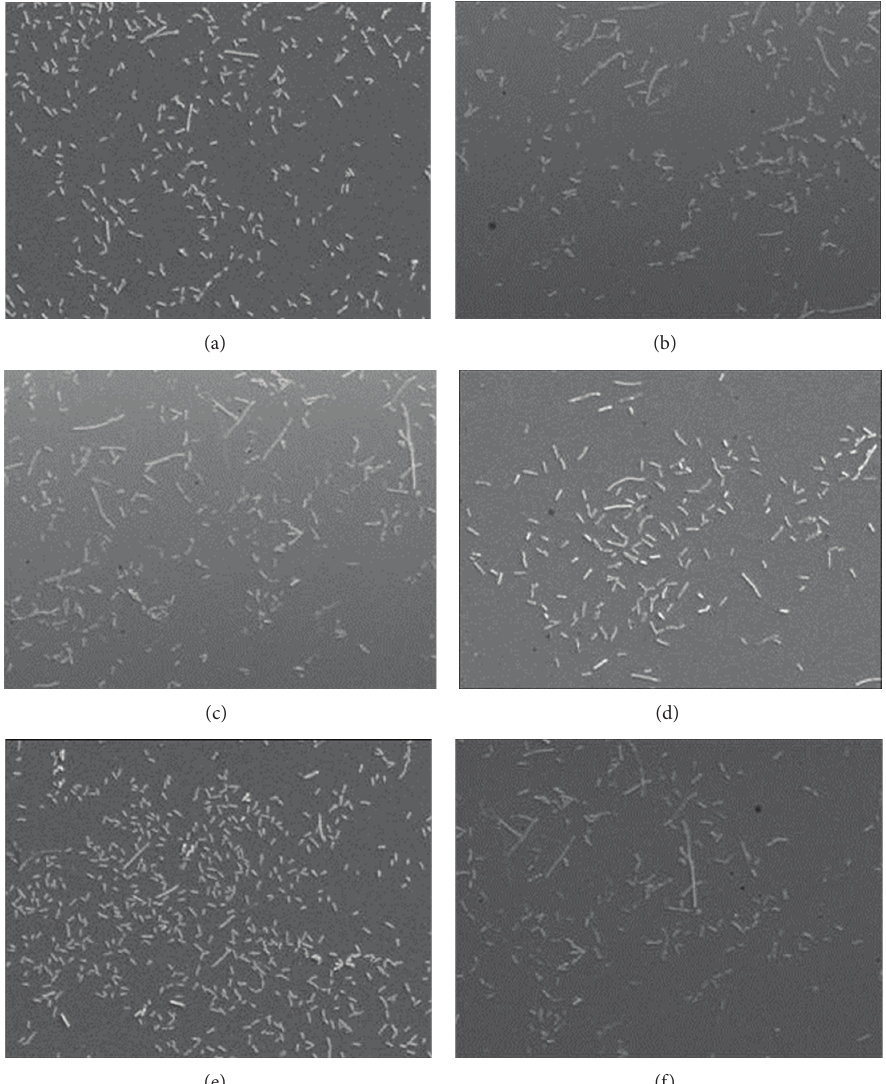
Figure 4: SEM pictures of the examined sample surface; (a) Fantocer; (b) Fantocer with TiO 2 coating; (c) Magnum AN; (d) Magnum AN with TiO 2 coating; (e) Wironit; (f) Wironit with TiO 2 coating.